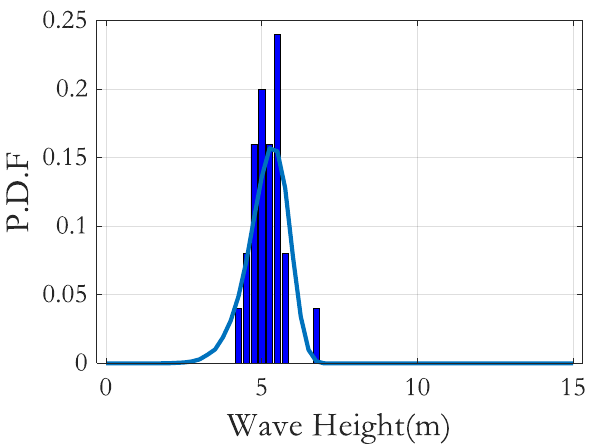
Figure 9. PDF of annual maximum 𝐻 𝑠 .